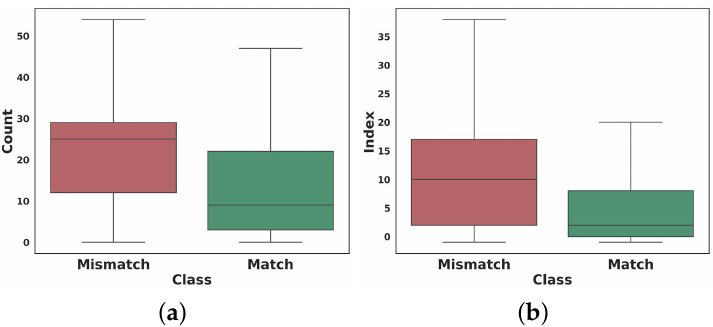
Figure 8. The comparison of hashtags in matched and mismatched content (the outliers are ignored), ( a ) the number of hashtags, ( b ) the Hashtag sequence index.